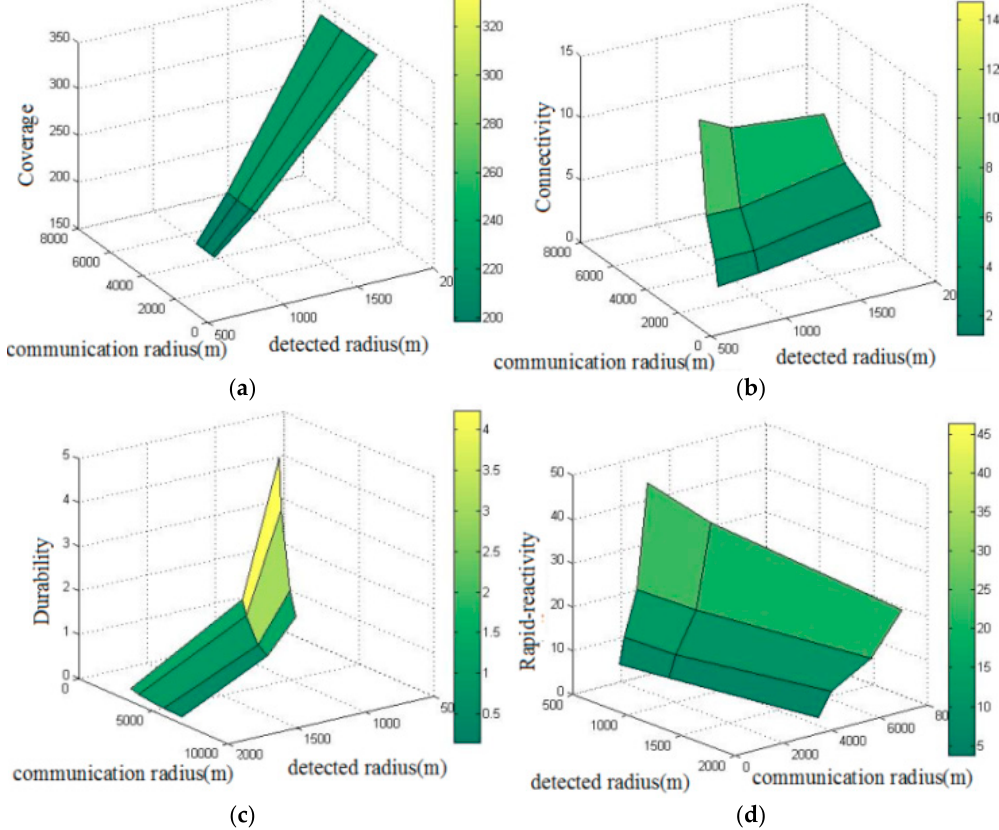
Figure 10. Relationship performances and parameters: ( a ) Coverage; ( b ) Connectivity; ( c ) Durability; ( d ) Rapid-reactivity.